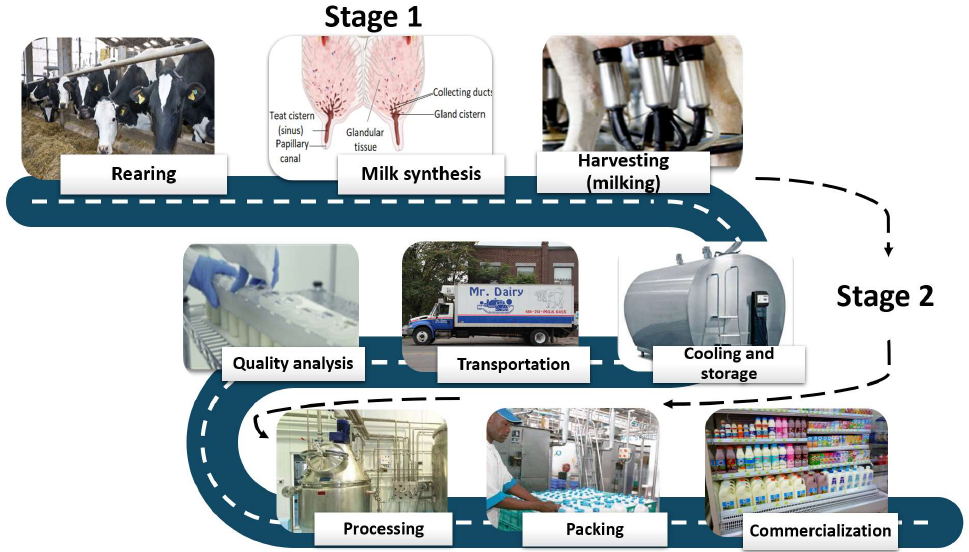
Figure 3. Milk way—from the rearing to the consumer.